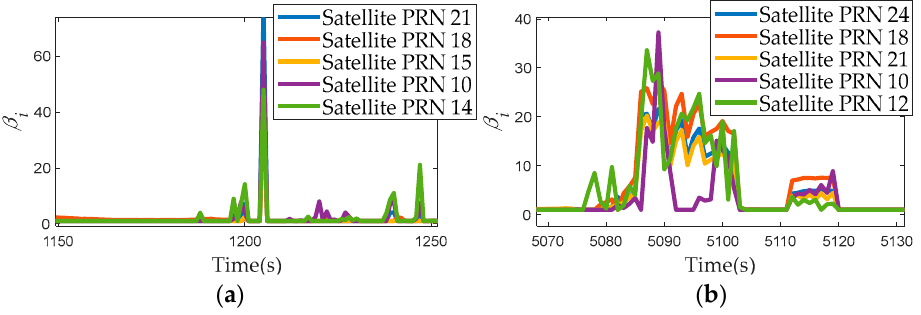
with respect to the five pseudo-range i